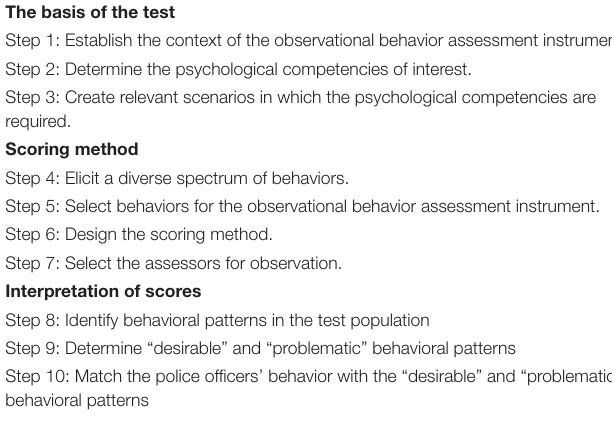
The basis of the